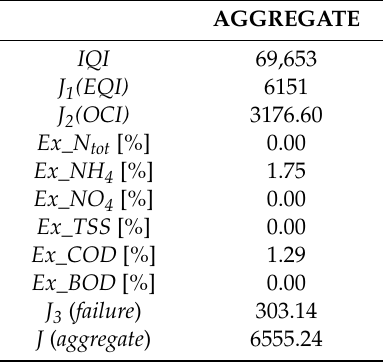
Table 6. Performance criteria in the aggregate regime of the wastewater treatment plant.